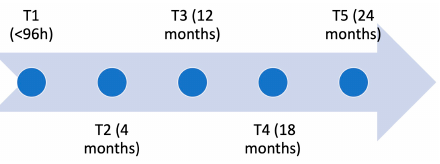
Figure 1. Timeline of the trial. At all timepoints, patients are tested with methods described in Table 2. Table 2. Times of clinical and technical examinations for patients with nerve lesions.